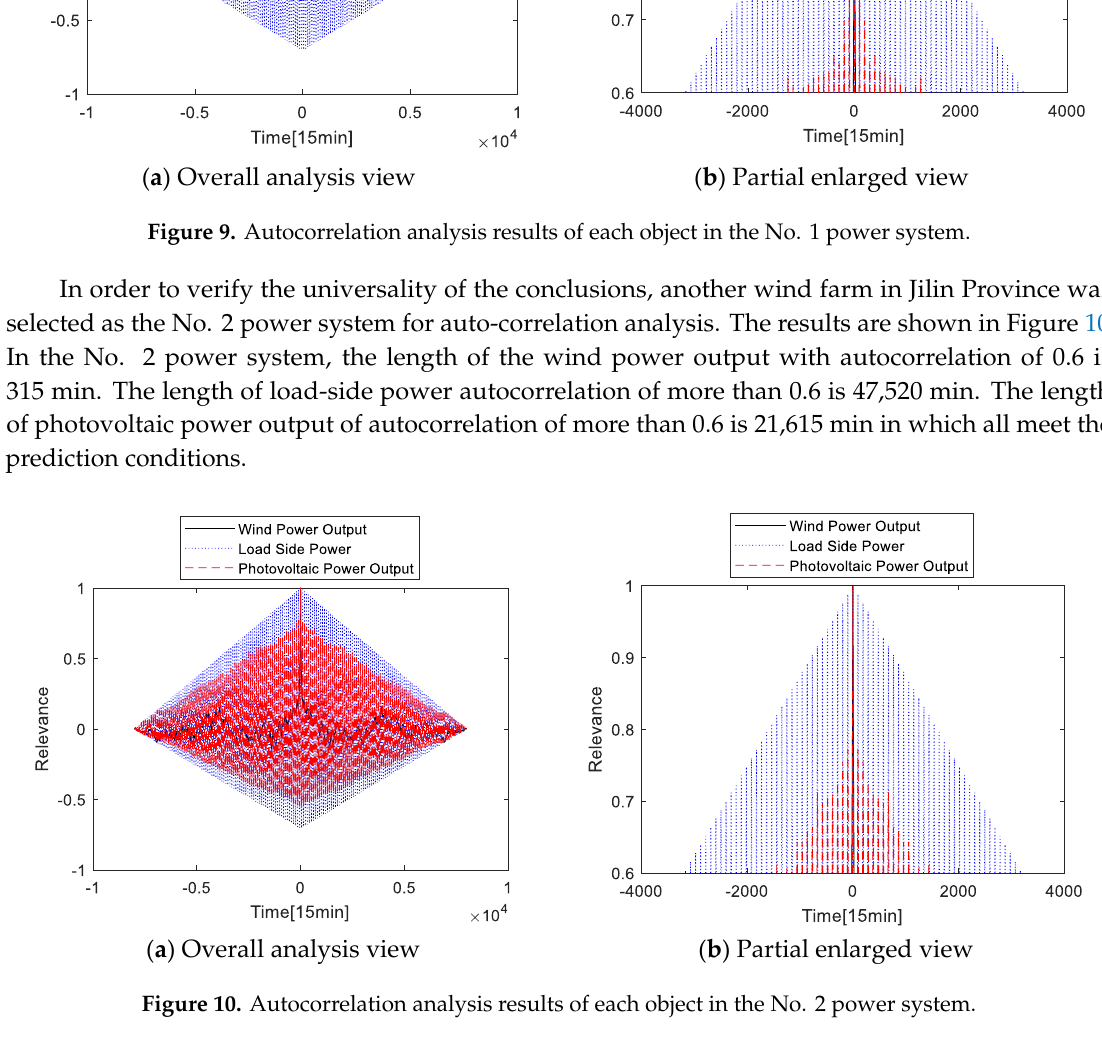
Figure 11. Prediction results of wind power output in the No. 1 power system. In Figure 11, the error (NRMSE) of using the BP neural network to predict the wind power output is 0.1530. The error (NRMSE) of using SVM to predict the wind power output is 0.1482.